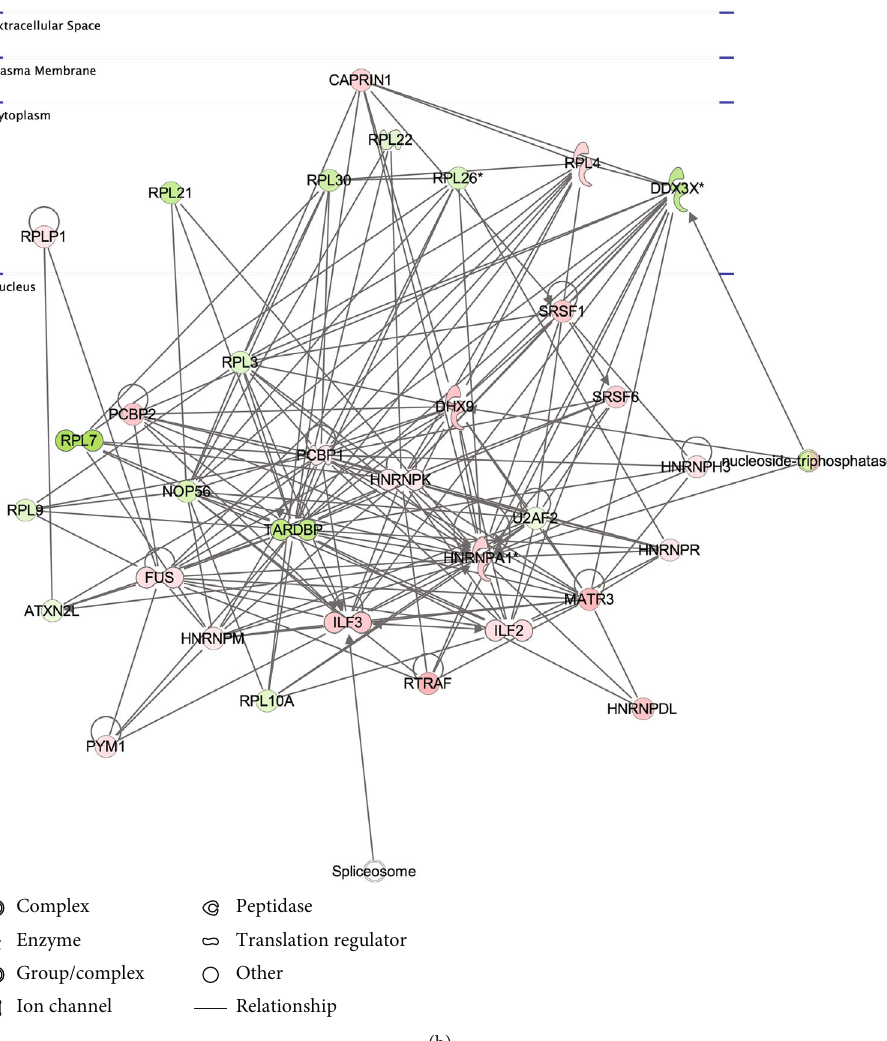
Figure 5: IPA network in hiPSCs/IMR90-1 and SH-SY5Y cells. (a) The top scoring IPA protein network for hiPSCs/IMR90-1 is “ cell-to-cell signaling and interaction, cellular assembly and organization ” and (b) in SH-SY5Y is “ cellular assembly and organization, cell-to-cell signaling and interaction, reproductive system development and function, ” both are depicted under the 400mM NaCl treatment condition. The shapes represent the molecular classes of the proteins. Red represents upregulation, green represents downregulation, and color intensity represents the relative magnitude of change in protein expression. Interactions are indicated by solid lines. The protein interaction networks were generated through the use of IPA